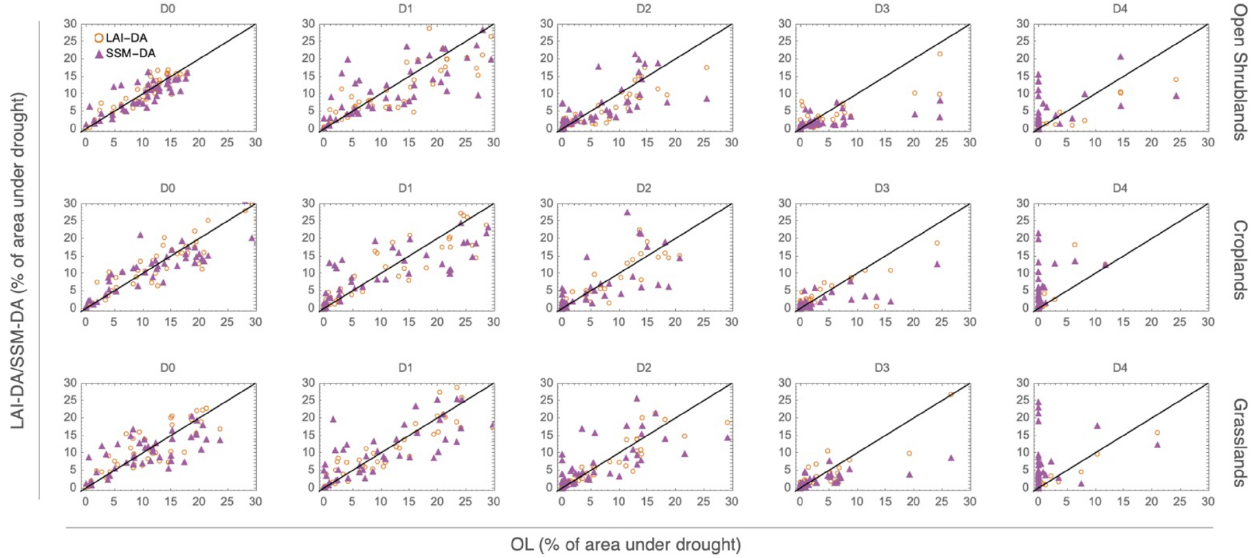
Figure 9. The scatterplot for the percentage of area under drought between OL and LAI-DA/SSM-DA for the five drought categories stratified by the three major land use types. The data for summertime (June–August) are excluded for this